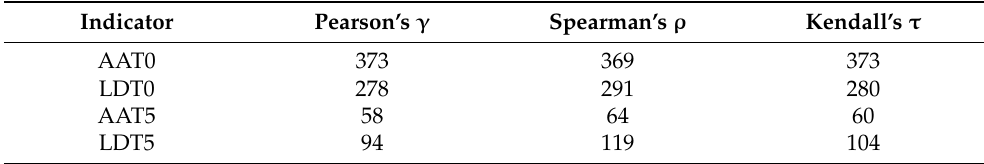
Figure 11. The Pearson correlation coefficient between annual maximum NDVI and ≥ 0 ◦ C ( a ) and ≥ 5 ◦ C ( b ) annual accumulated temperature during 2001–2016, checked by two-tailed test, α = 0.05, and inclination rate of respective AAT with the determination coefficient R 2 of regression analysis ≥ 0.5 during 1998–2018 in the source region of the Yellow River. Table 12. The number of verified Pearson’s γ between annual series of NDVI and indicators during 2001–2016 among 1200 girds by two-tailed T test in the SRYR.